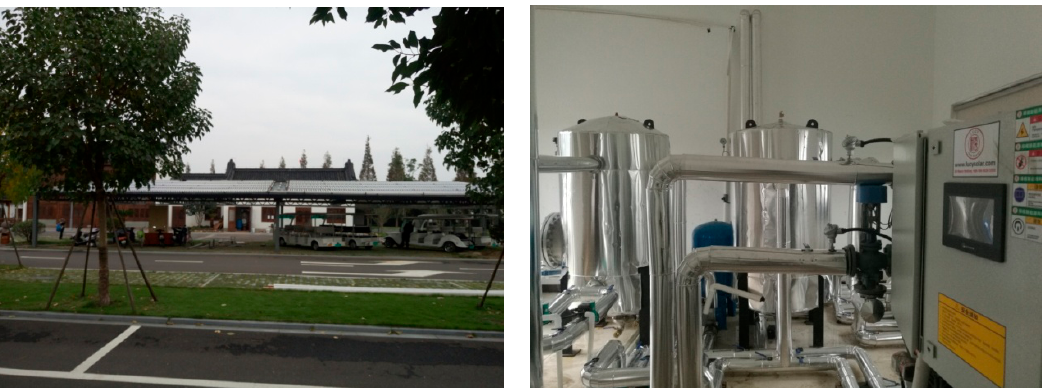
Figure 5. Photos of the (left) solar collector field on the roof of a steel-structure parking shed and the (right) equipment room.